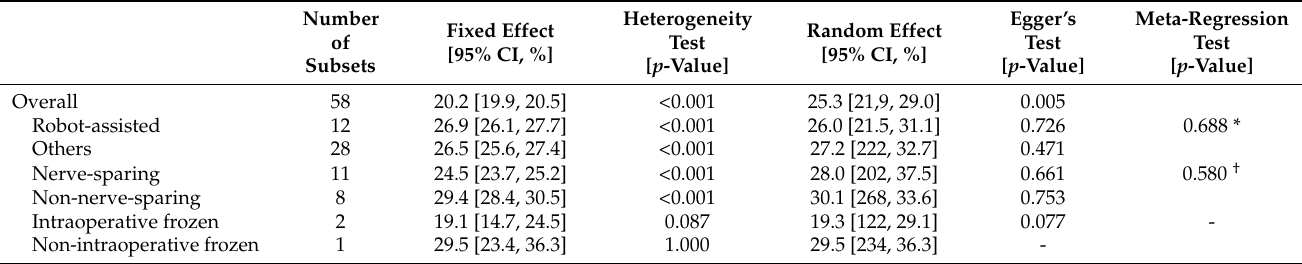
CI: confidence interval. * Comparison between robot-assisted and other radical prostatectomy. † Comparison between nerve-sparing and non-nerve-sparing radical